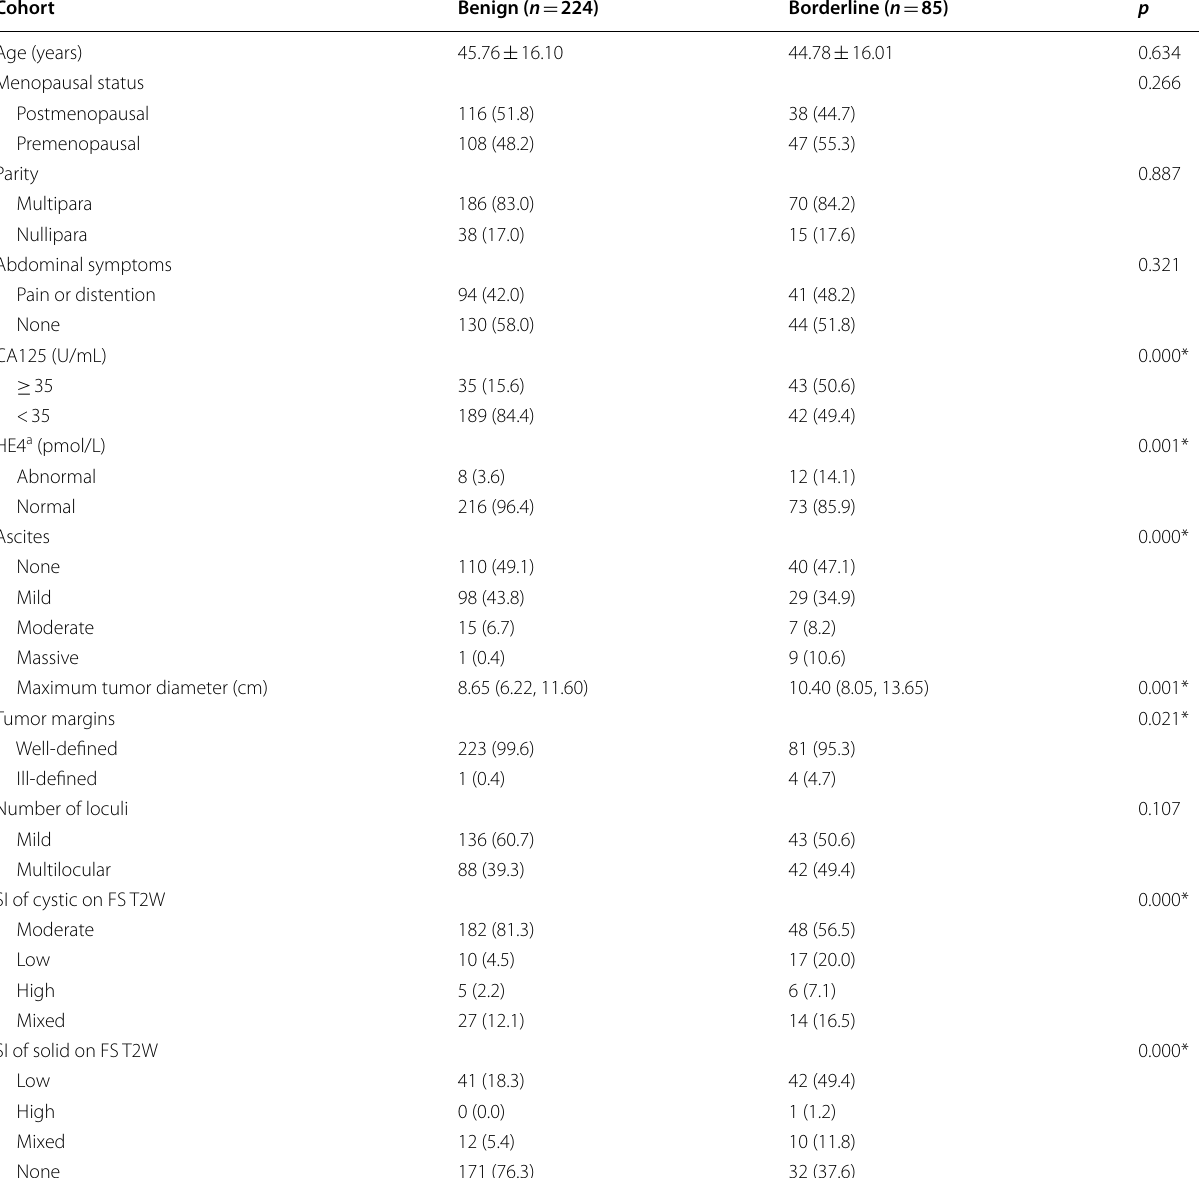
Table 2 Clinical and radiological characteristics for benign and borderline EOTs in training